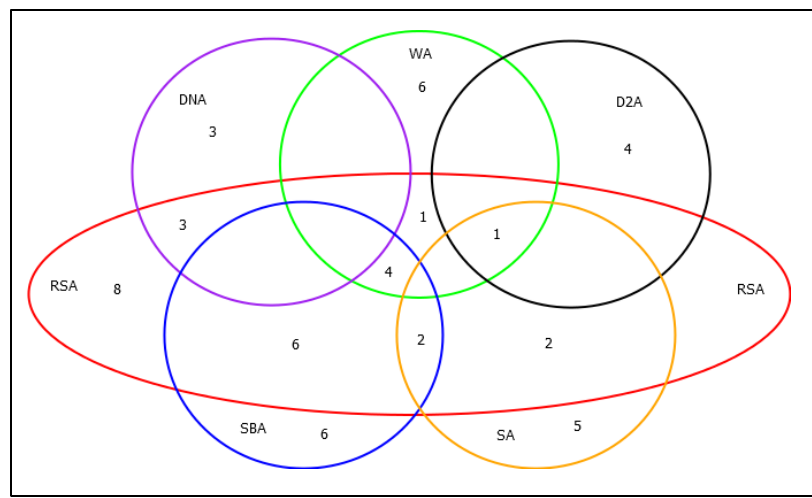
Figure 9. Correlation between mitigated attacks.